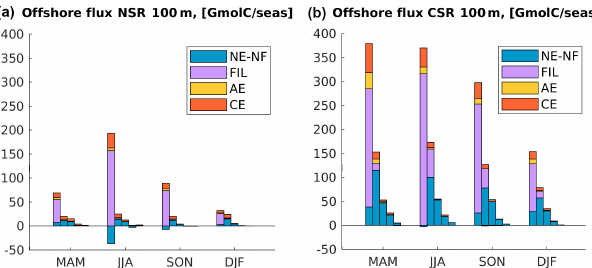
Figure 6. Magnitude of the offshore flux of C org integrated in the first 100m of depth in (a) northern and (b) central CanUS. Each group of bars represents a different season. For each season, each one of the five bars represents the flux through a specific offshore boundary, i.e., an isoline of distance from the coast. From left to right in each group: 100km offshore, 500km offshore, 1000km off- shore, 1500km offshore, and 2000km offshore. Colors in each bar represent the flux contribution by a certain type of structure: non- eddy–non-filament (NE–NF), filaments (FIL), anticyclones (AEs), and cyclones (CEs). Positive and negative contributions to the flux through each boundary are plotted separately in order to make them clearly